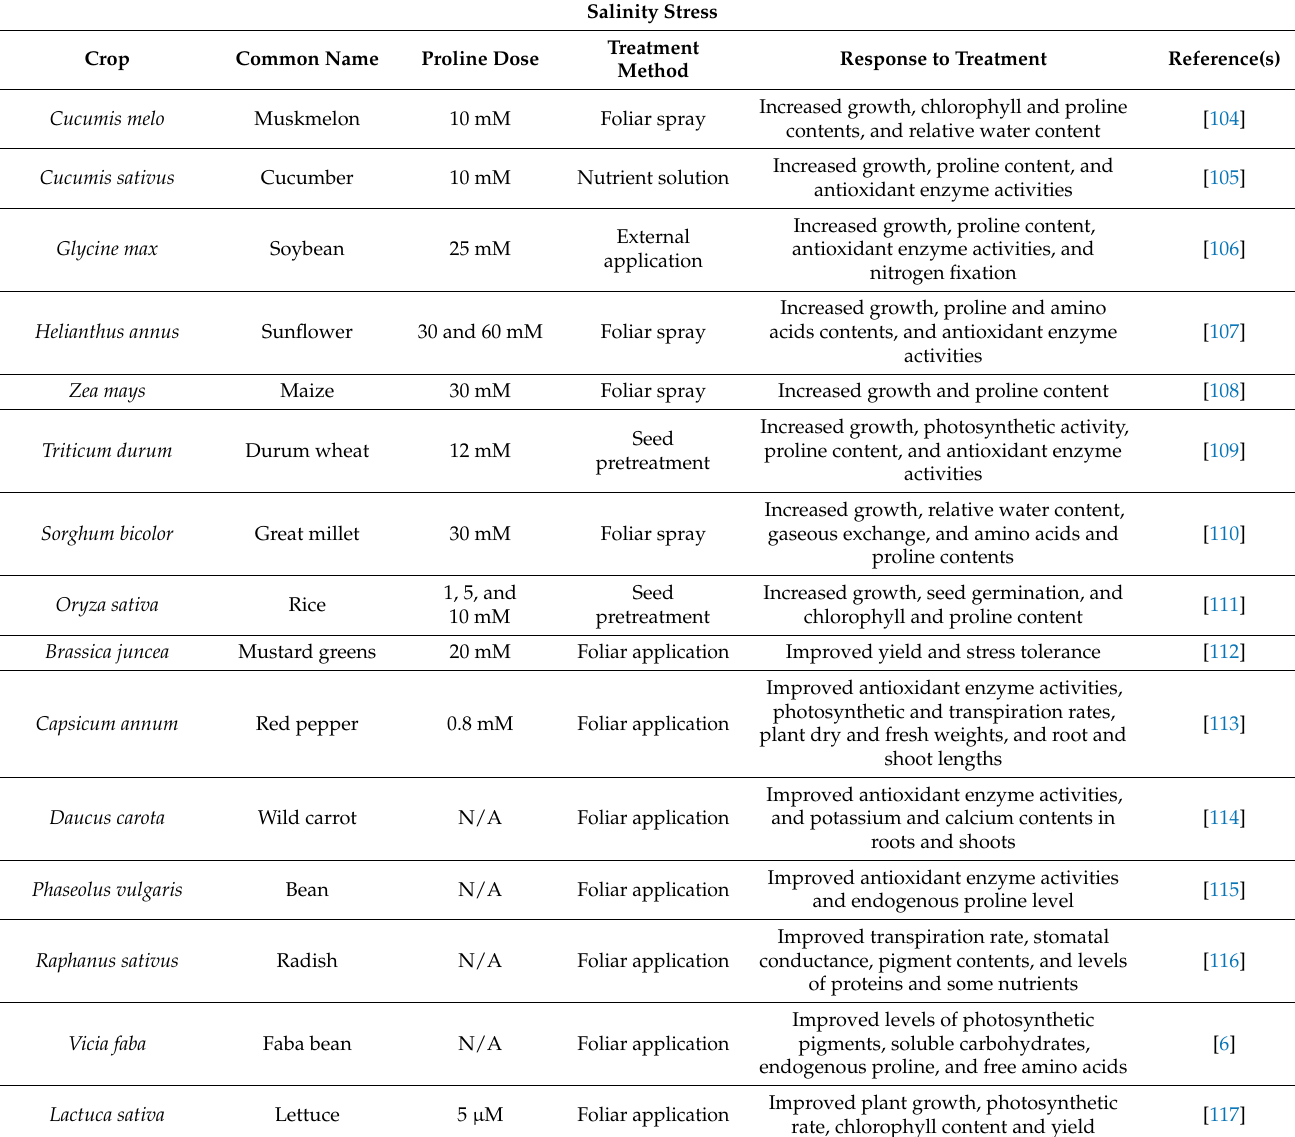
Table 12. Physiological responses of various crops to proline treatment against salinity